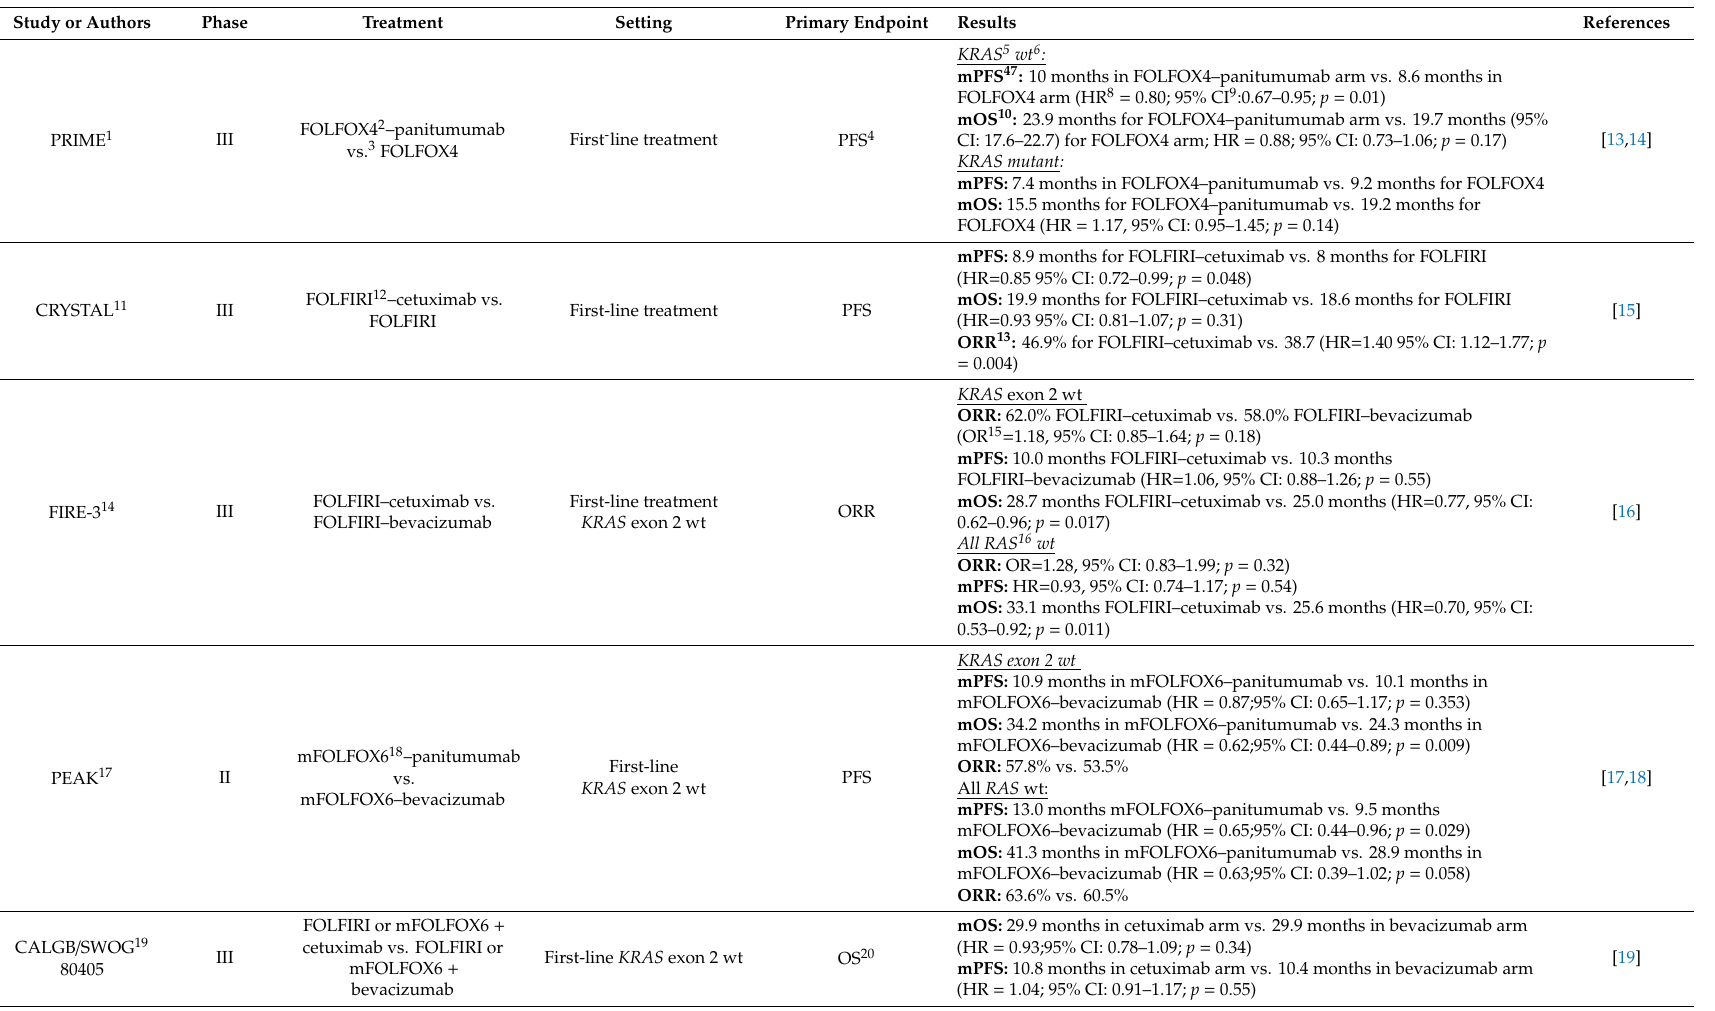
Table 1. Anti-epidermal growth factor receptor (EGFR) treatment